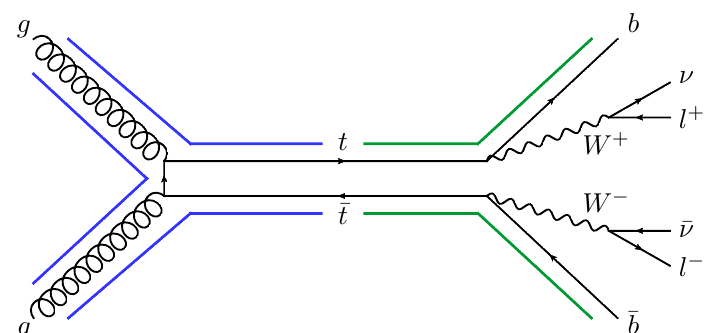
Figure 2 . Diagram for the process gg ! t (cid:22) t ! b (cid:22) b l + l (cid:0) (cid:23) (cid:22) (cid:23) . In the large- N c limit, the radiation can be split into a set of color dipoles. The color dipoles associated to the production of the t (cid:22) t pair are shown in blue, the ones associated to the decay in green. The full LL cross section will include the emissions from all (cid:12)ve